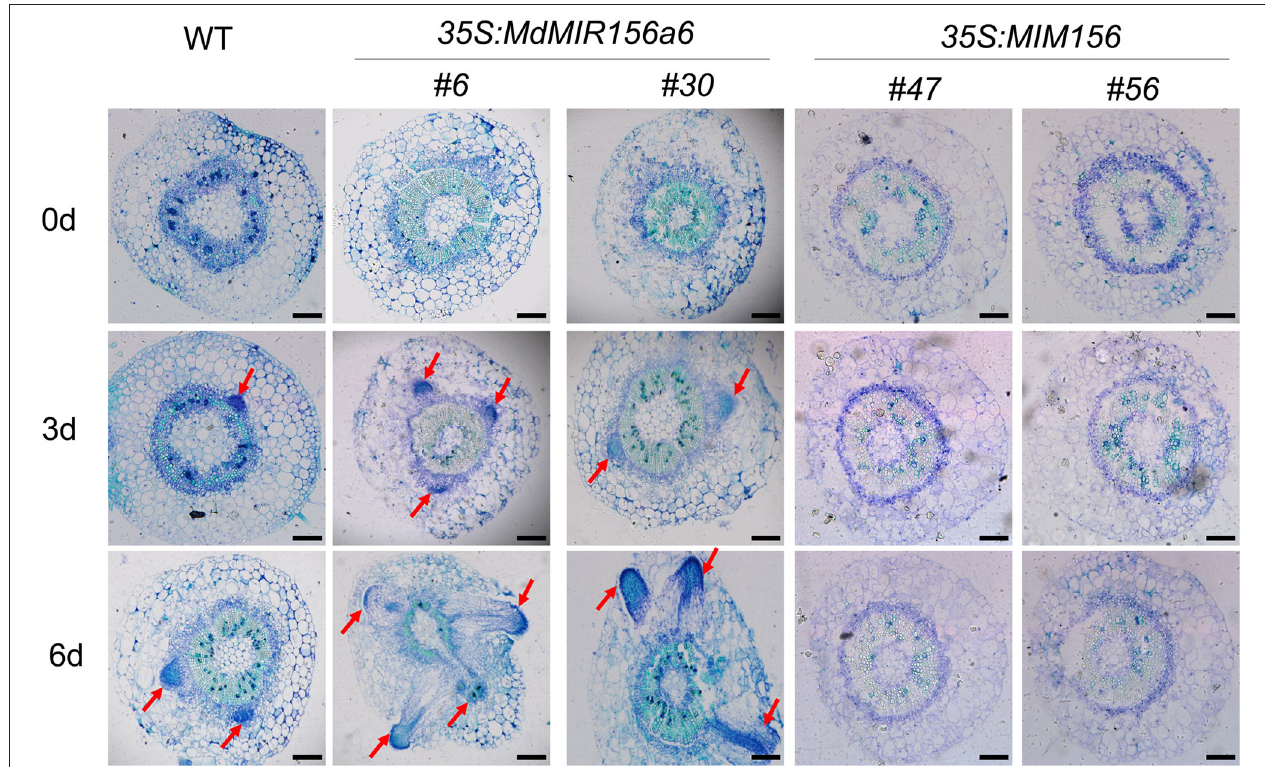
FIGURE 4 | Histological features of WT, 35S:MdMIR156a6, and 35S:MIM156 tobacco stems during adventitious root formation. Toluidine Blue-stained cross-section of the stem of WT, 35S:MdMIR156a6, and 35S:MIM156 at 0, 3, and 6 d after subculture on MS medium. Arrows indicate initial emerging adventitious roots and adventitious root primordia. Scale bars = 200 µ